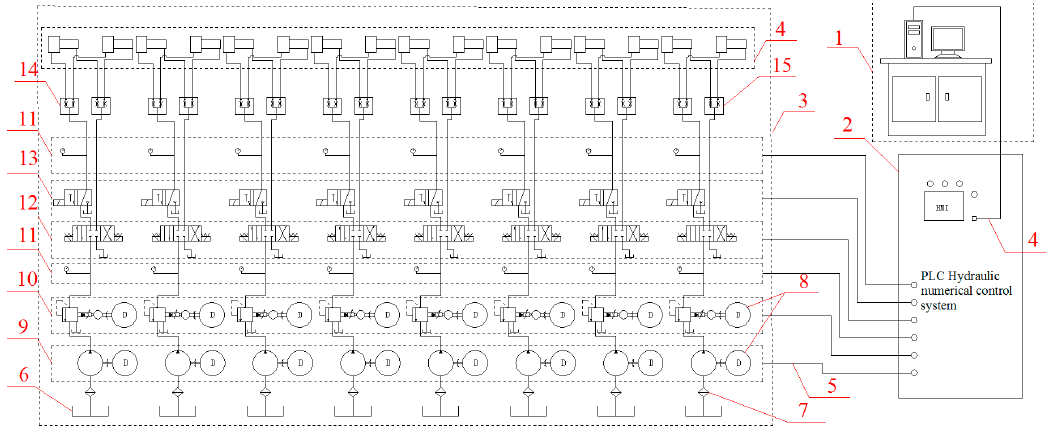
Figure 4. Design diagram of oil way of the system. 1: Personal computer (PC) monitoring